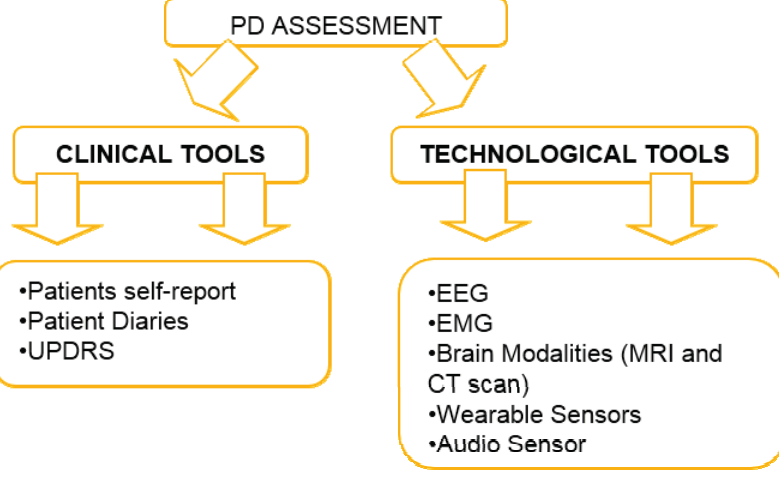
Figure 2. Summary of overall assessment of